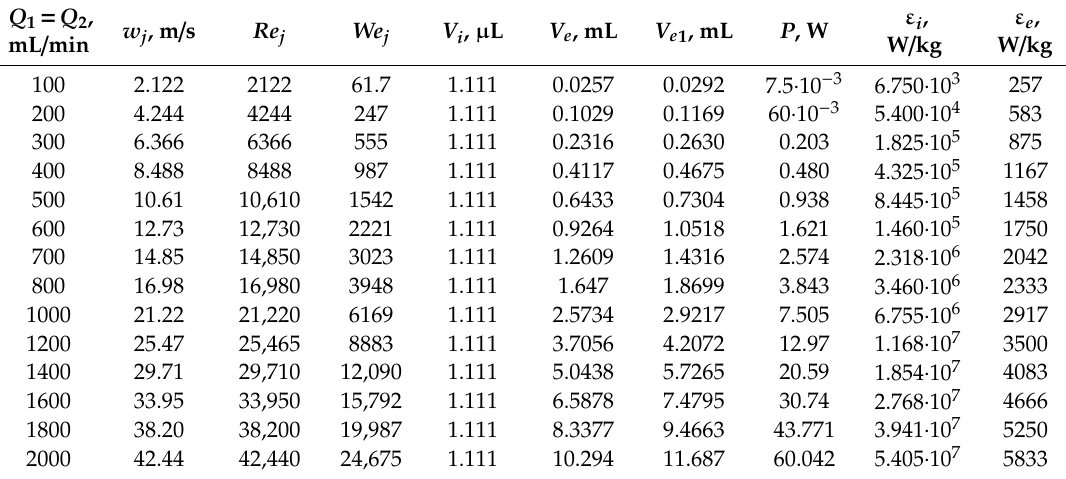
Table 3. Volume of the jets collision zone V i , sheet volume V e , energy dissipation rate ε , and